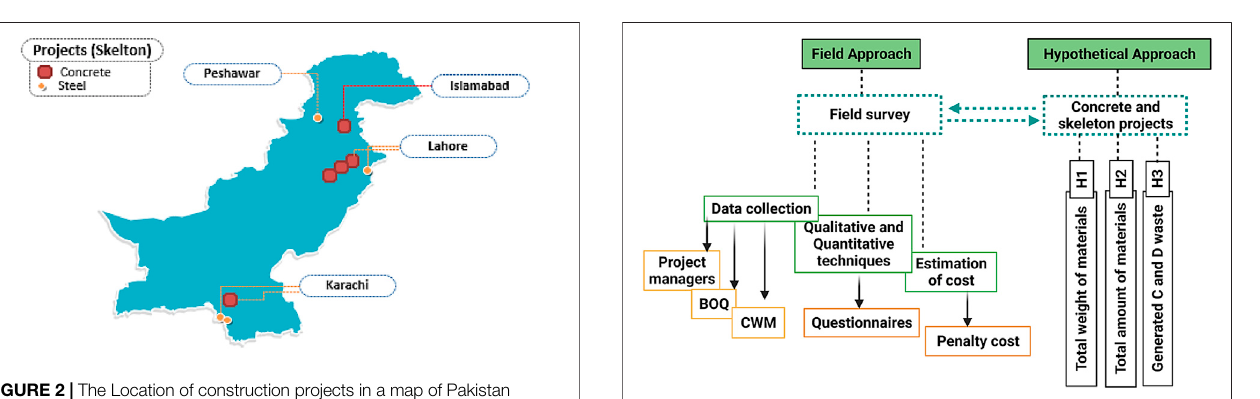
FIGURE 2 | The Location of construction projects in a map of Pakistan (city-wise).